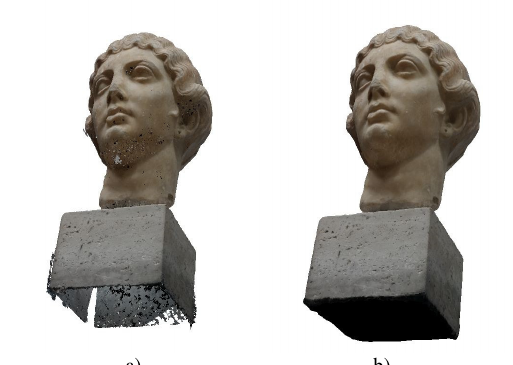
Figure 11 Agisoft mesh generation with: a) bad illumination and standard processing; b) same illumination and “smooth” mesh